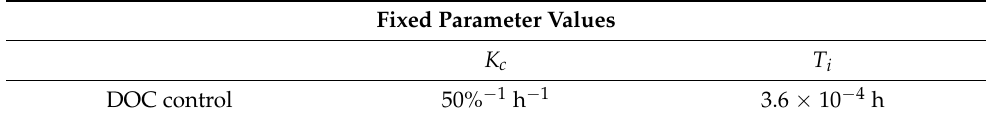
Table 3. Fixed PI controller parameters for standard